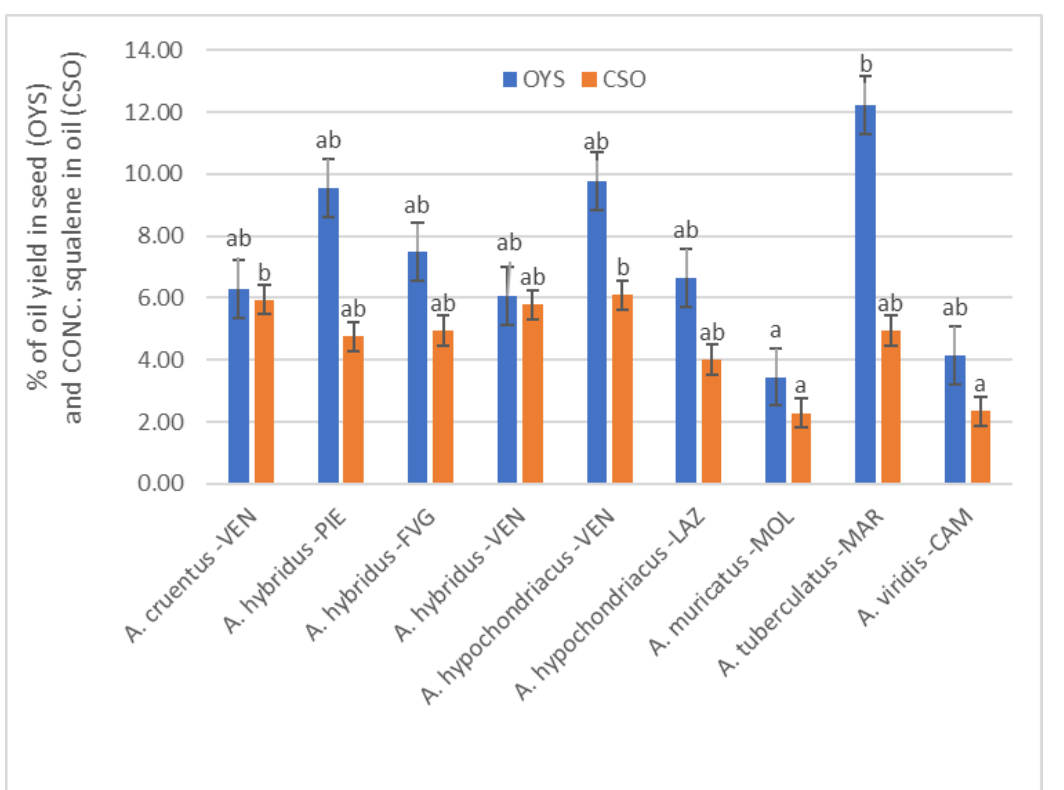
Figure 1. Percentage of oil yield in seed (OYS) and concentration of squalene in oil (CSO) for the six species of Amaranthus collected. Different letters (a – d) indicate significant differences according to Tukey’s HSD test ( p < 0.05).